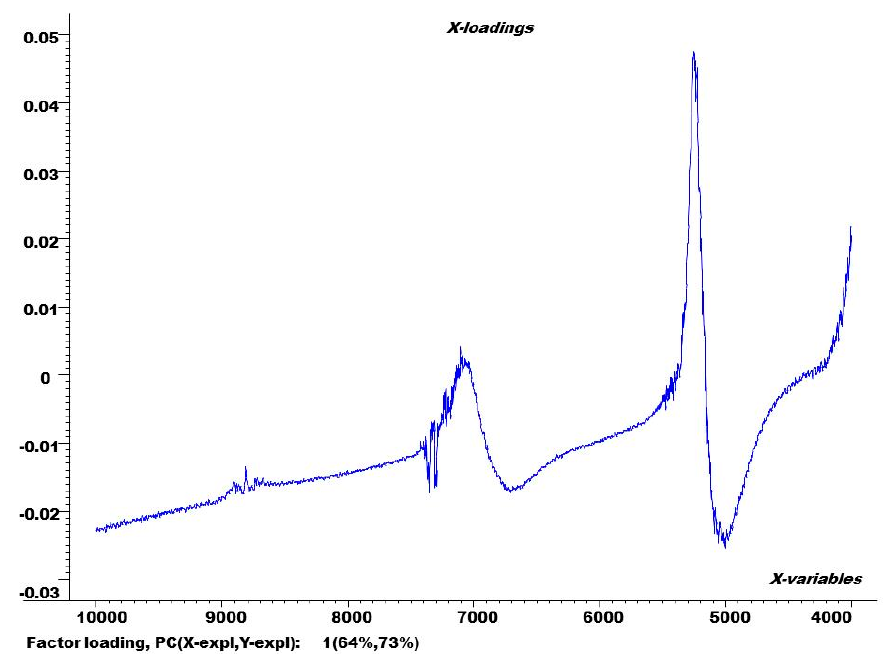
Figure 3. Loading plot for factor 1 of the PLSR model.